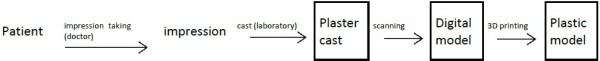
Scheme of the process of formation of plaster casts, digital model and 3D printed model from impression taking to utilization of the digital data as template for 3D printer.